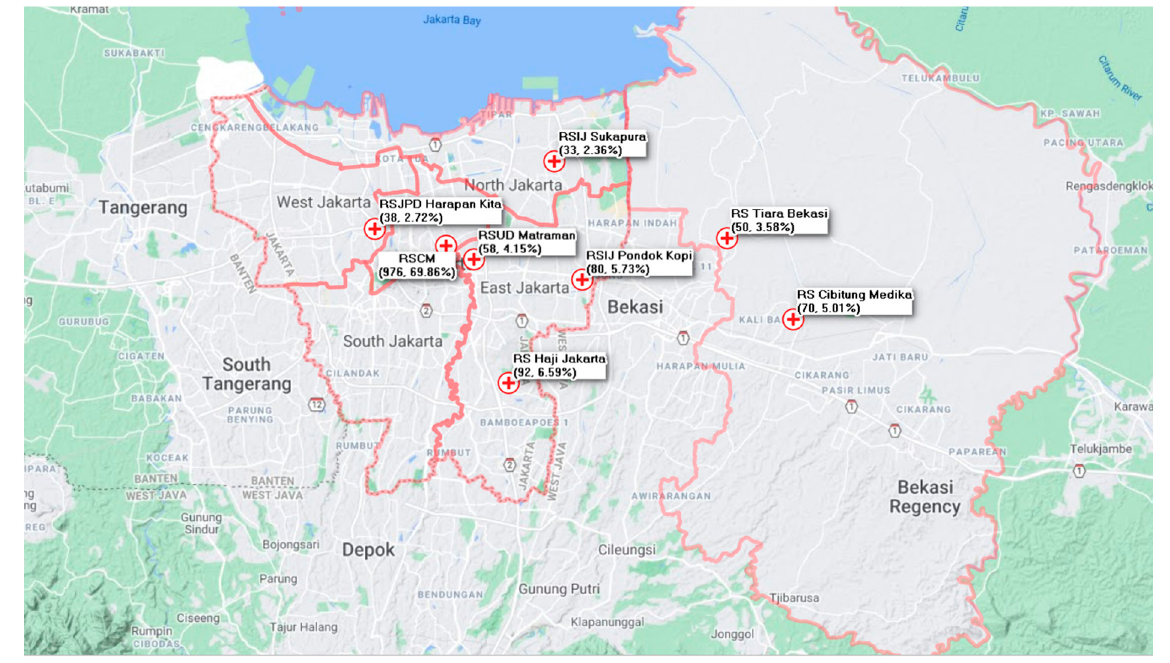
Figure 1. Participating hospitals in the Greater Jakarta Area.